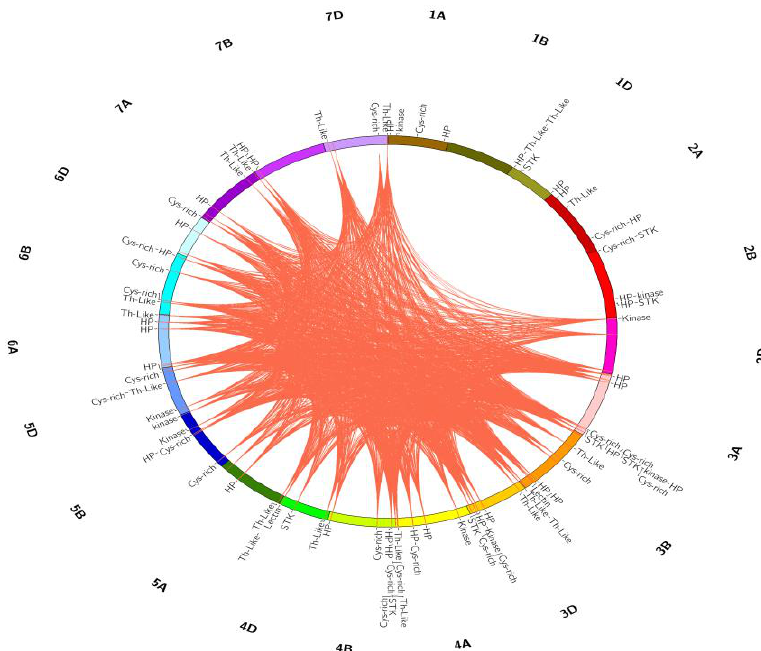
Figure 1 : The Circos diagram for the position of predicated anti-fungal genes and their proposed gene description, where the inner connections represent similar genes on separate chromosomes with sequence similarity over 75%.